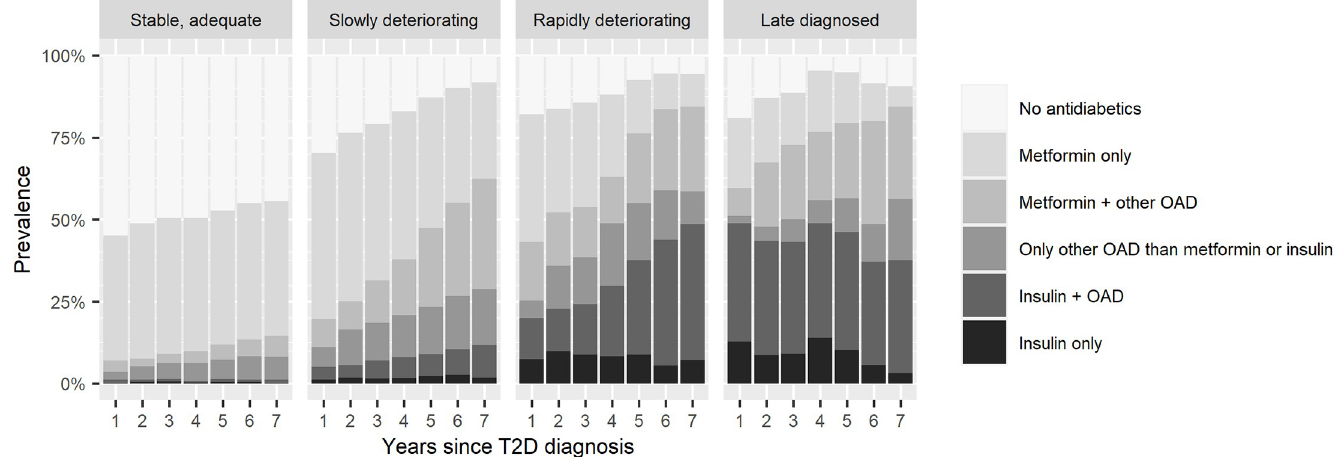
Fig 2. Prevalence of diabetes medication use by HbA1c trajectories. OAD, oral antidiabetic drugs or GLP-1 analogues (incl. metformin, sulfonylureas, combinations of oral blood glucose lowering drugs, glitazones, DPP-4 inhibitors, glinides, GLP-1 analogues, and SGLT2 inhibitors).